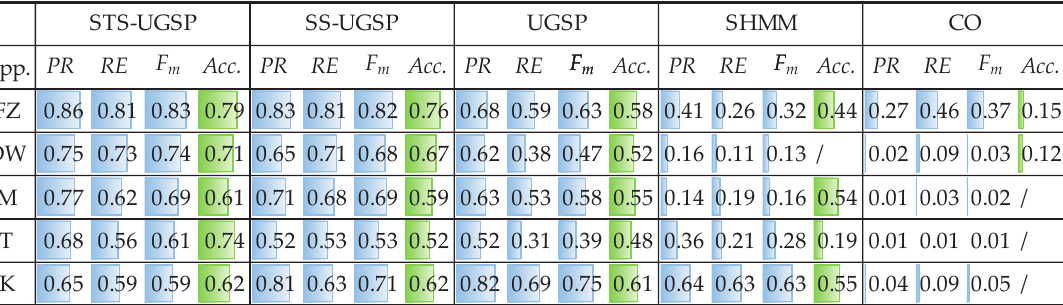
Figure 7. NILM Performance comparison for REFIT House